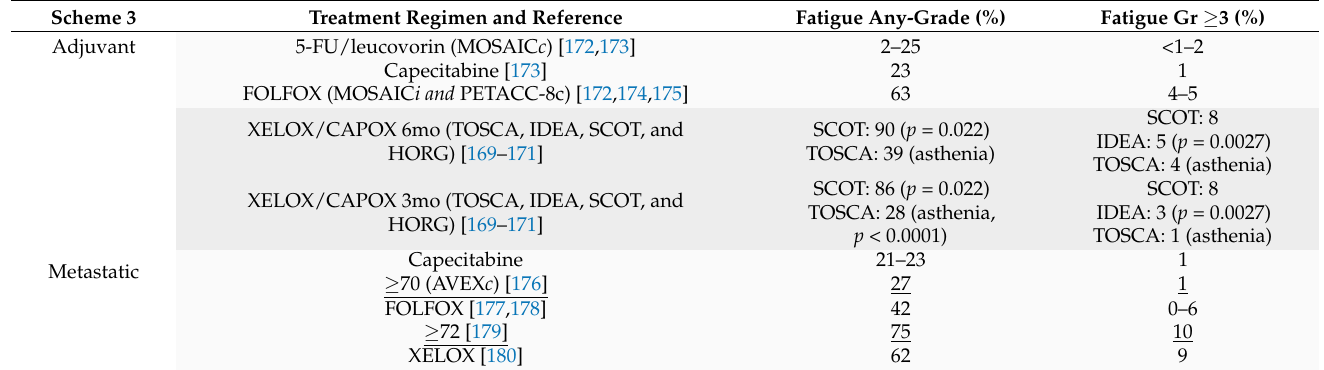
Table 4. Fatigue events in the most common anticancer regimens for colorectal